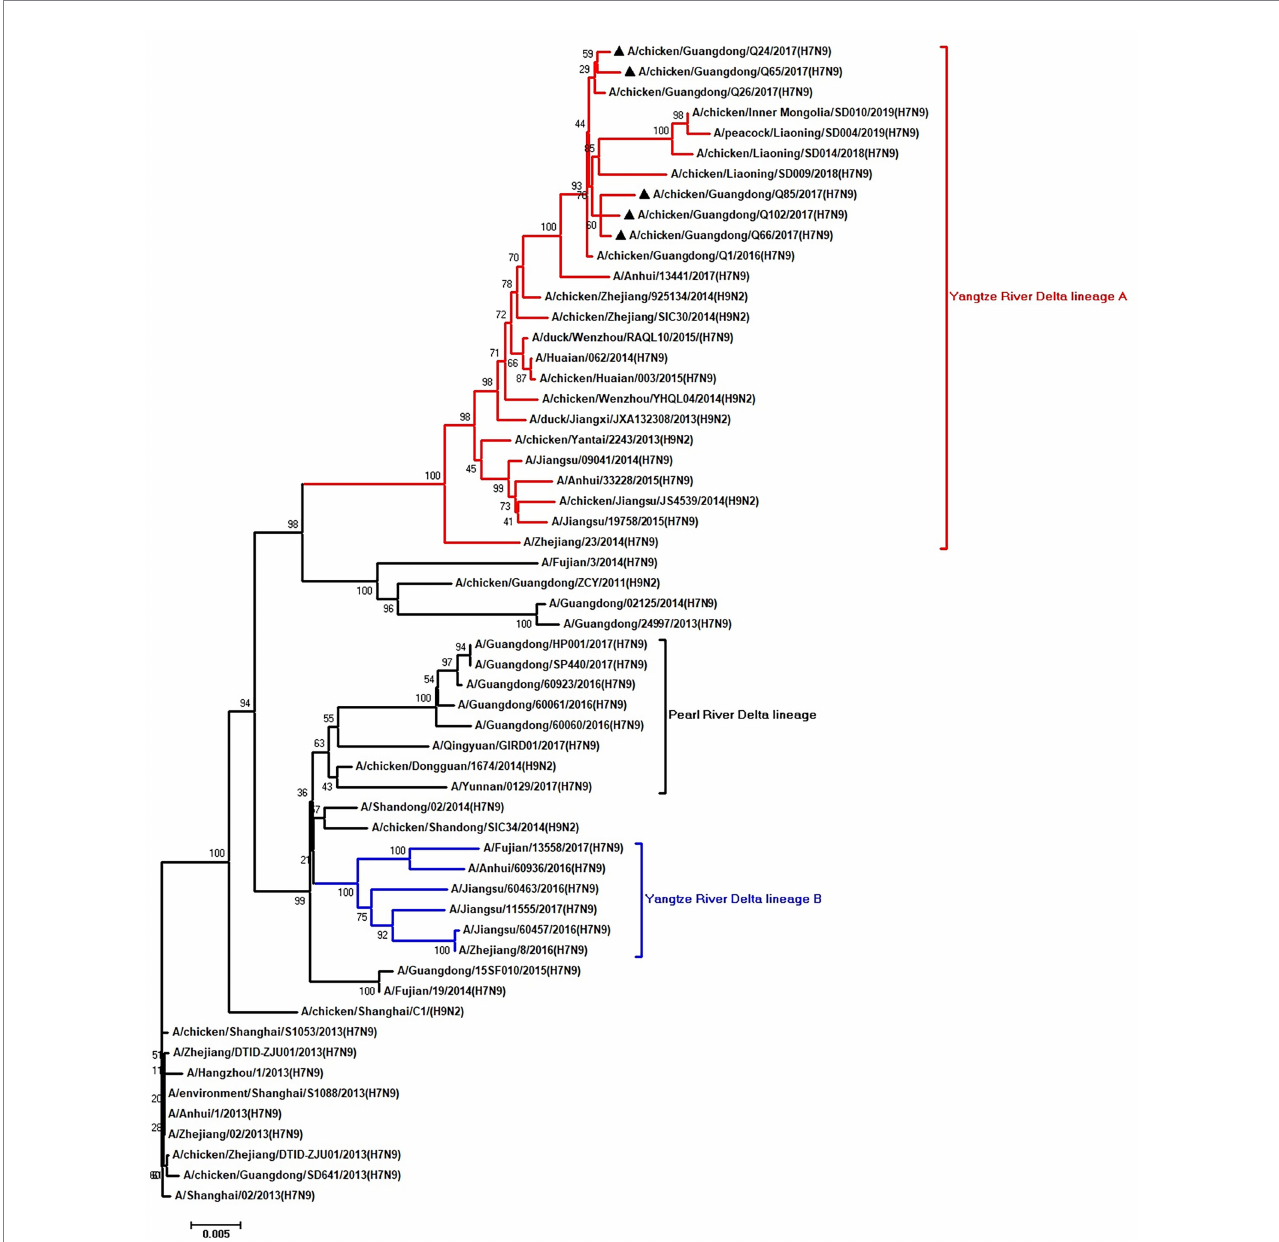
FIGURE 3 Phylogenetic analysis of PB2. The tree was constructed by using the neighbor joining method with the Maximum Composite Likelihood model and MEGA version 5.2 (www.megasoftware.net/) with 1,000 bootstrap replicates based on the following sequences: PB2: nt 28–2,307. Except our five isolates, other virus sequences were downloaded from GenBank. Triangles indicate the viruses characterized in this study. The scale bar indicates the branch length and corresponds to 0.002 estimated amino acid substitutions per